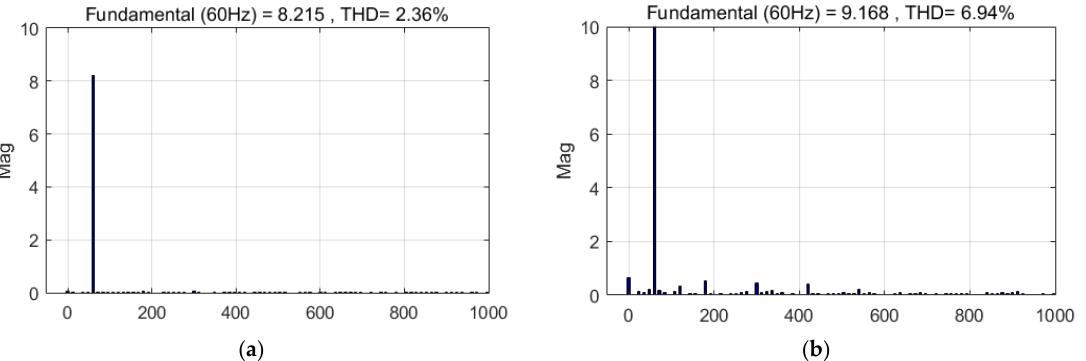
Figure 15. FFT analysis of grid current i g on the novel hybrid real-time simulator. ( a ) L g = 1 mH; ( b ) L g = 0 mH.